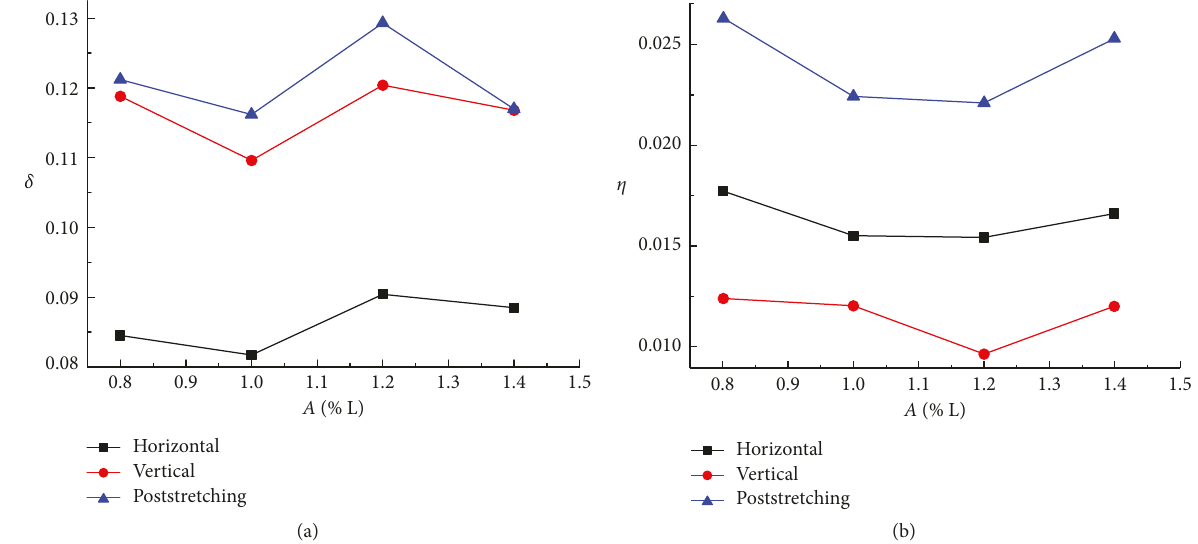
Figure 11: Influence of prestretching on cross-sectional distortion during each process.